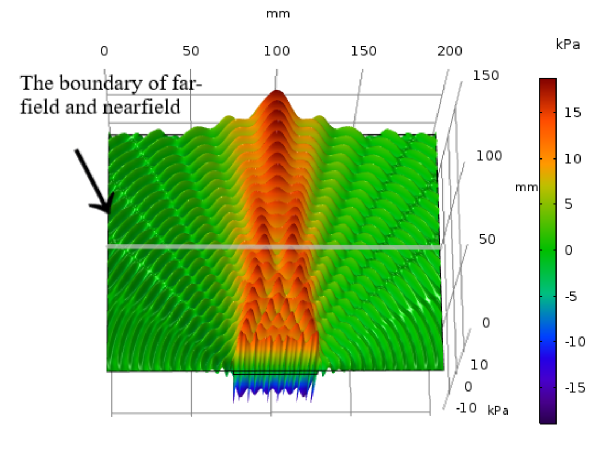
Figure 5. 3-D acoustic pressure distribution on the vertical cross-section of the